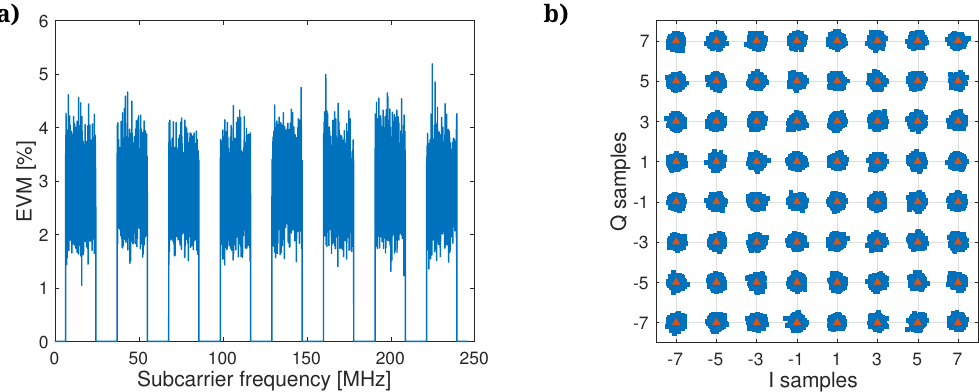
Figure 5. Percentage EVM against subcarrier frequency ( a ), and received constellation ( b ) for 3-level PWM with full dynamic, 8 aggregated 20-MHz LTE-like channels, 64-QAM, P rx =